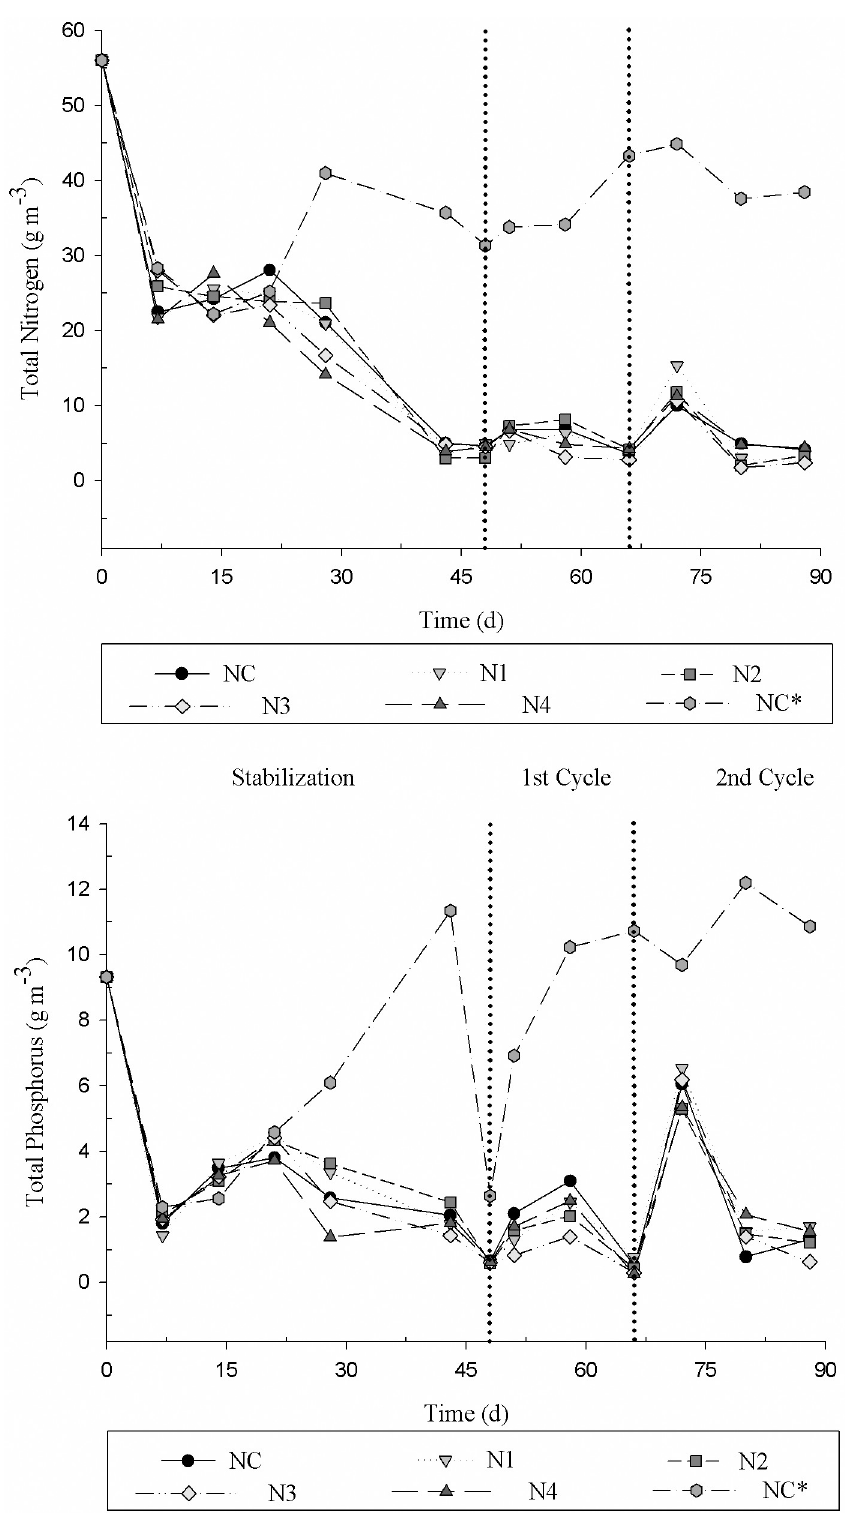
Fig 11. Total nitrogen and total phosphorus concentration, corrected as a function of ET c of the effluent for the different treatments. NC = 0; N1 = 5; N2 = 25; N3 = 50 and N4 = 100 μ M GA 3 ; NC � control without the cultivation of Tifton 85